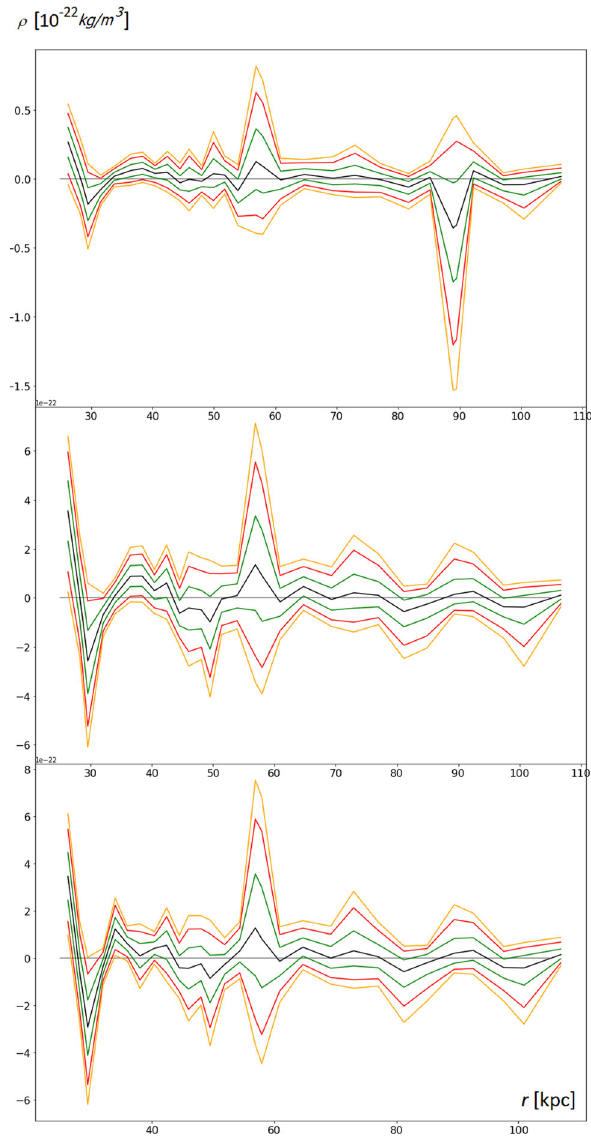
Fig. 3 Median (blackline)andlowerandupperboundsof68% (green lines),95% (redlines)and99% (orangelines)confidenceintervalsof ρ calculatedusingthree-pointschemeforthecalculationofderivativesfor three combinations of distance of Sun from the galactic center and Sun orbital velocity around the galactic center: ( R 0 = 8 . 0 kpc, v 0 = 200 km/s) (top), ( R 0 = 8 . 3 kpc, v 0 = 244 km/s) (middle) and ( R 0 = 8 . 5 kpc, v 0 = 220 km/s) (bottom). Even though it was declared that we have confined the analysis to radial distances above 28 kpc, a few points belowthislimitaredrawninthesegraphsinordertoshowthedownward trend of ρ at lower radii